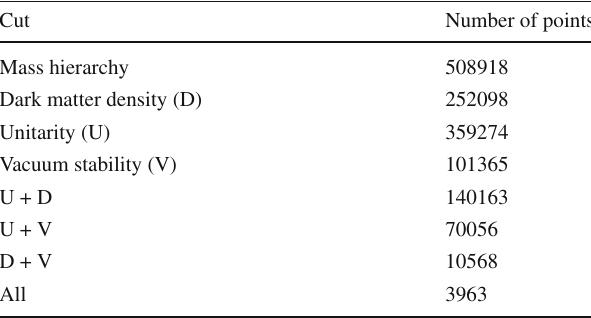
Table 2 Points left over after each cut. The raw sample contained one million points. D refers to the cut on the dark matter density, U to that on unitarity, and V to that on vacuum stability. Details see text